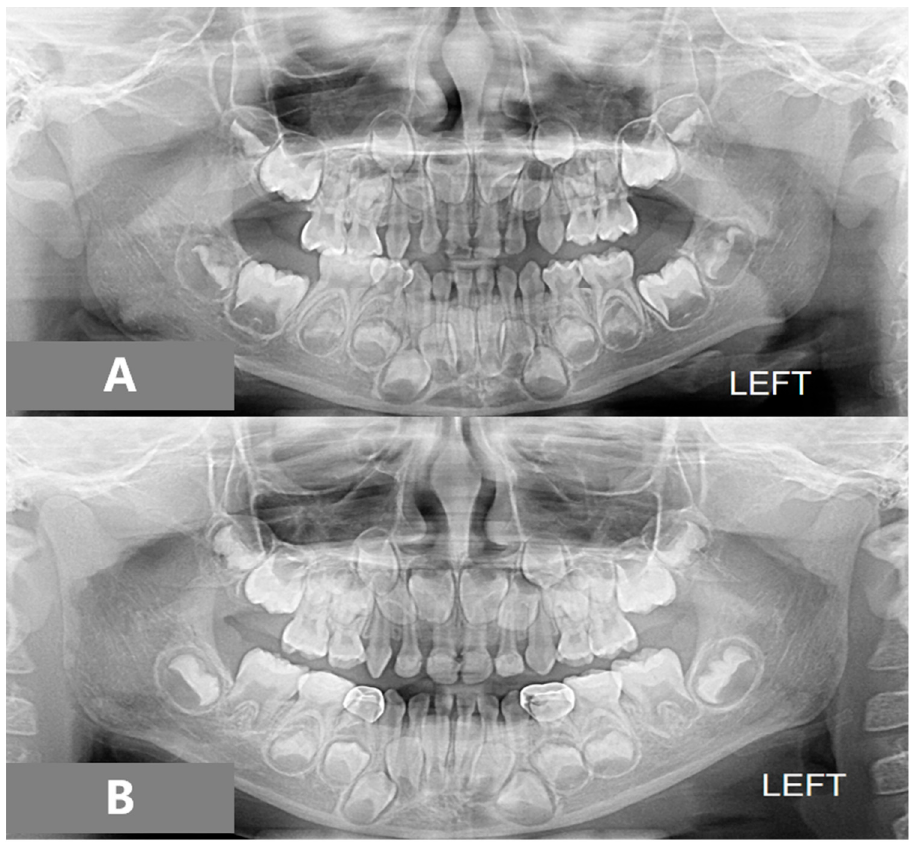
Figure 4. Panoramic radiographs: ( A ) pre-treatment, ( B ) post-treatment.